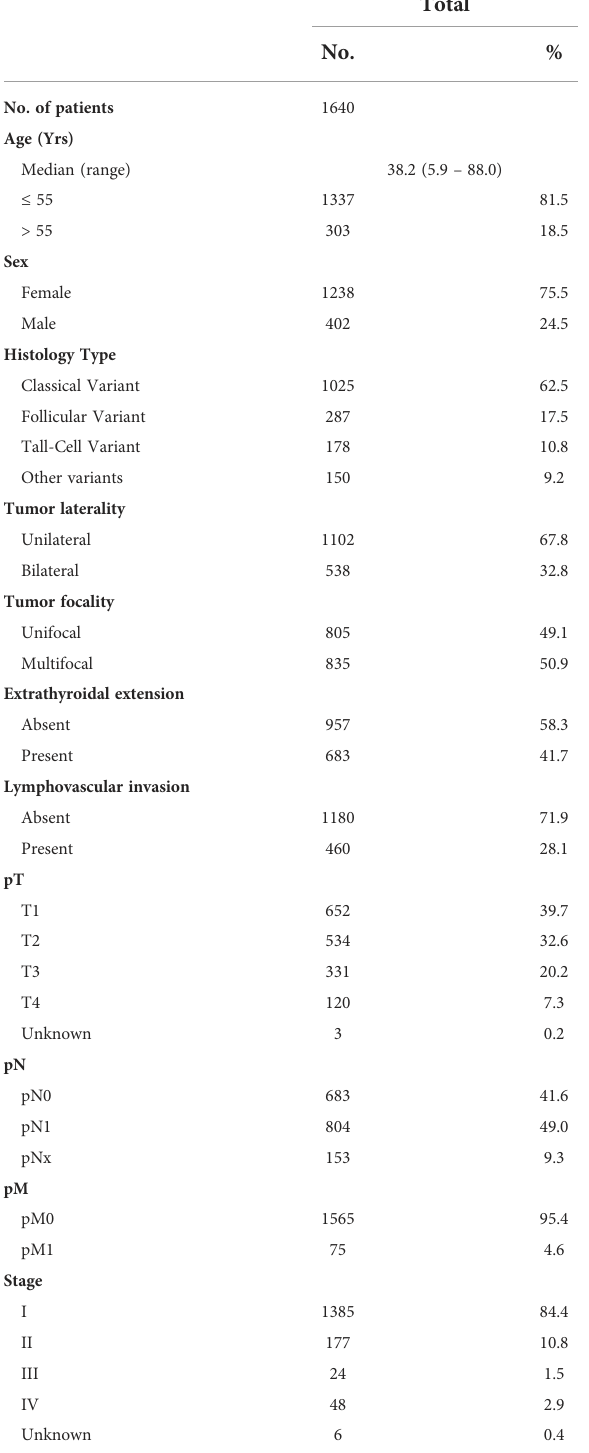
TABLE 1 Clinico-pathologic characteristics of papillary thyroid